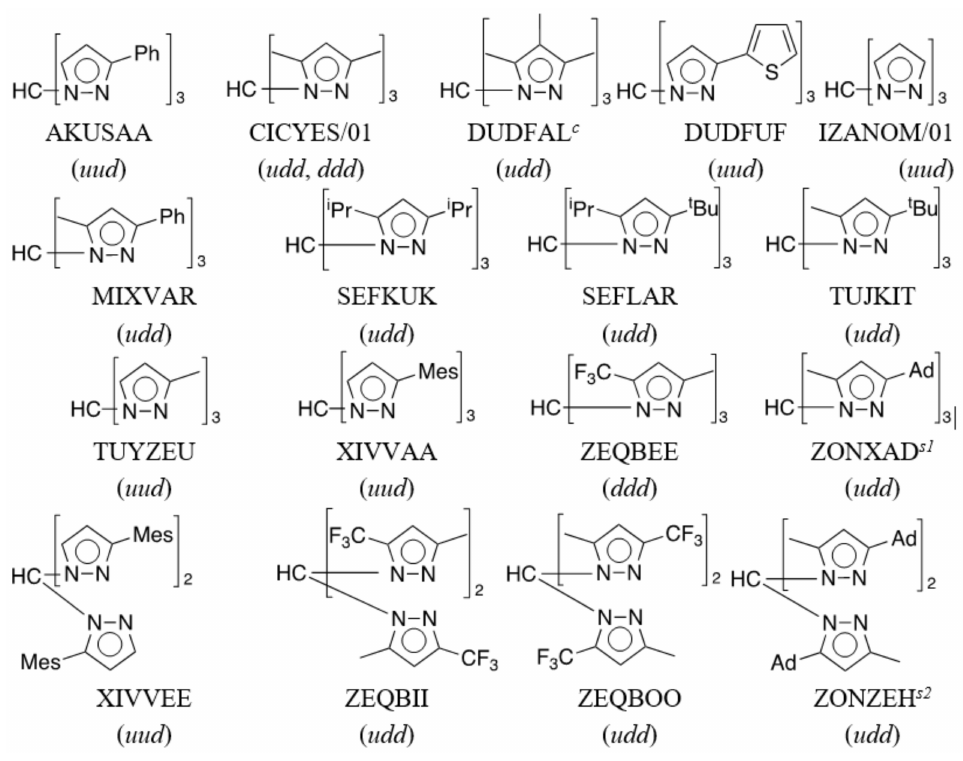
Figure 7. Molecular diagram of 17 trispyrazolylmethane derivatives recorded in the CSD version 5.39, updates to Feb 2018. ( c cocrystallized with tmeda, s1 benzene and s2 n-hexane solvates).